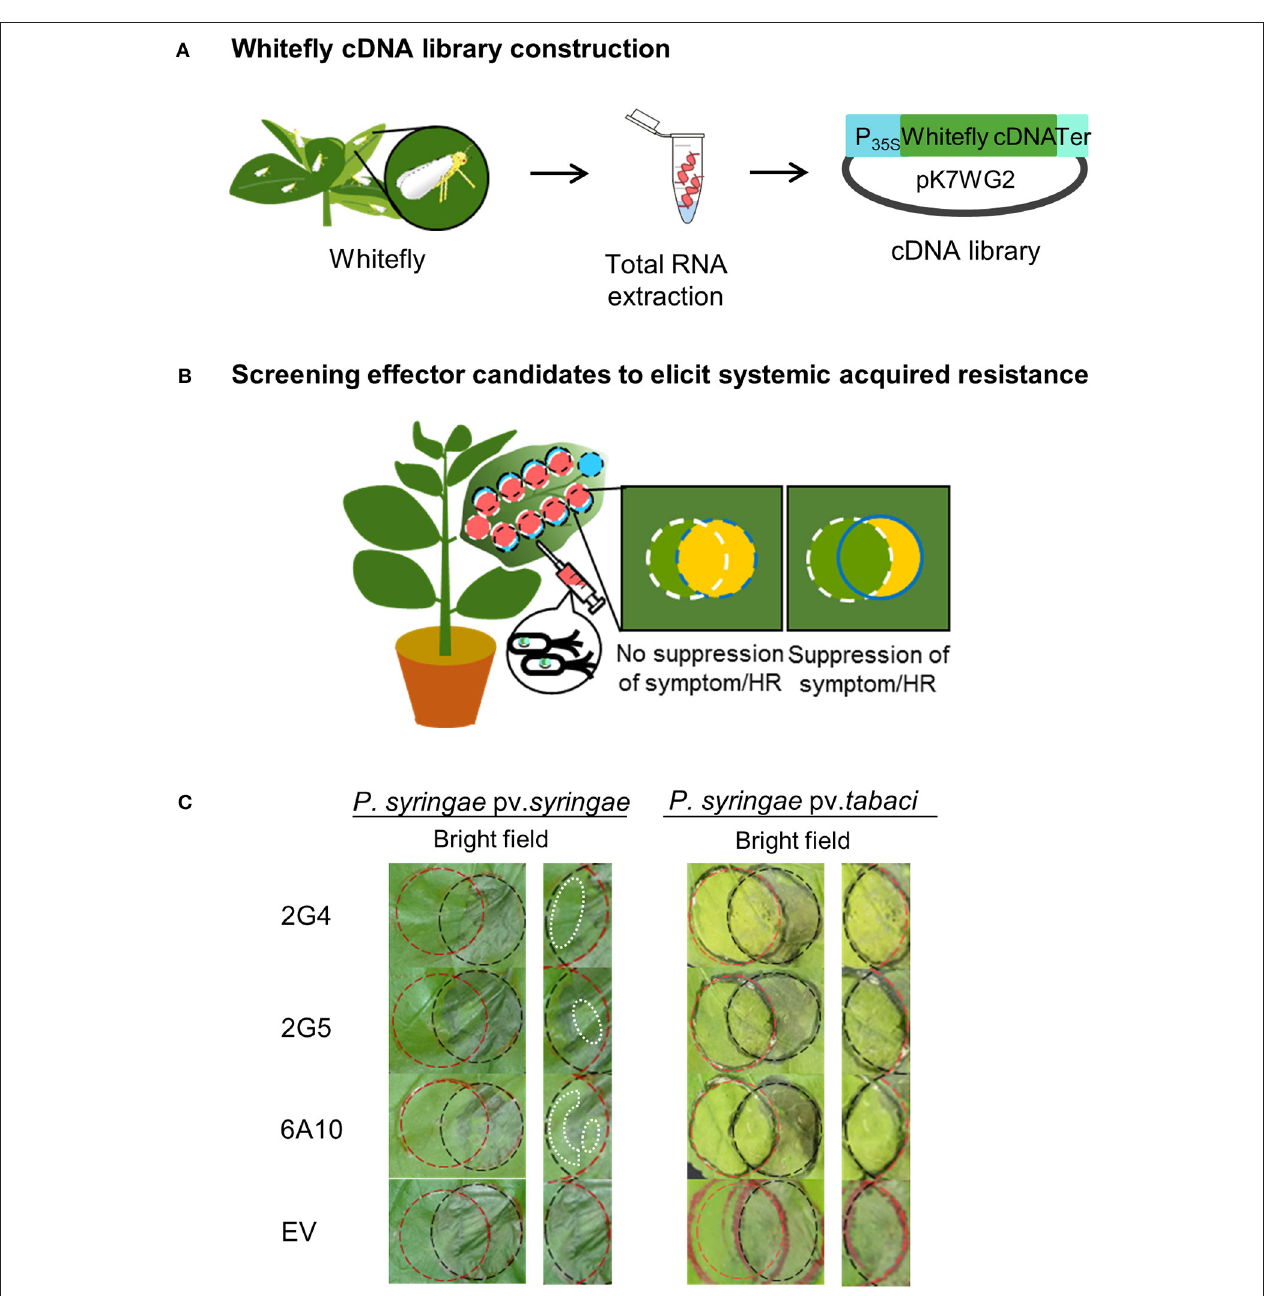
FIGURE 1 | Screening system to identify candidate whitefly effectors that induce plant immunity. (A) Whitefly cDNA library construction. Extraction of total RNA from whitefly during infestation of Nicotiana benthamiana leaves. The cDNA library from whitefly mRNA was constructed in Agrobacterium tumefaciens using a binary vector system. (B) Screening candidate effectors that elicit systemic acquired resistance against virulent Pseudomonas syringae pv. tabaci and avirulent (a non-host pathogen) Pseudomonas syringae pv. syringae . To identify whitefly effectors that activate plant pathogen immunity, cross-circle infiltration was performed with cDNA clones and pathogens, and the suppression of disease symptoms caused by Pta and the hypersensitive response (HR) caused by Psy at 1–5 days after pathogen infiltration were evaluated. (C) Suppression of the HR and symptoms by whitefly cDNA clones 2G4, 2G5, and 6A10. The white dotted lines in the left panel indicate the suppressed HR. The empty vector (EV) treatment showed no inhibition of the HR and symptom development in the intersecting area. The experiment was repeated three times with similar results.